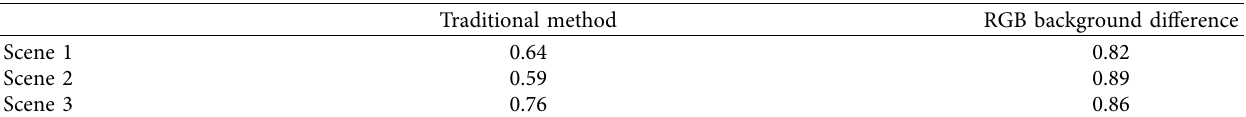
Table 3: Recall rate